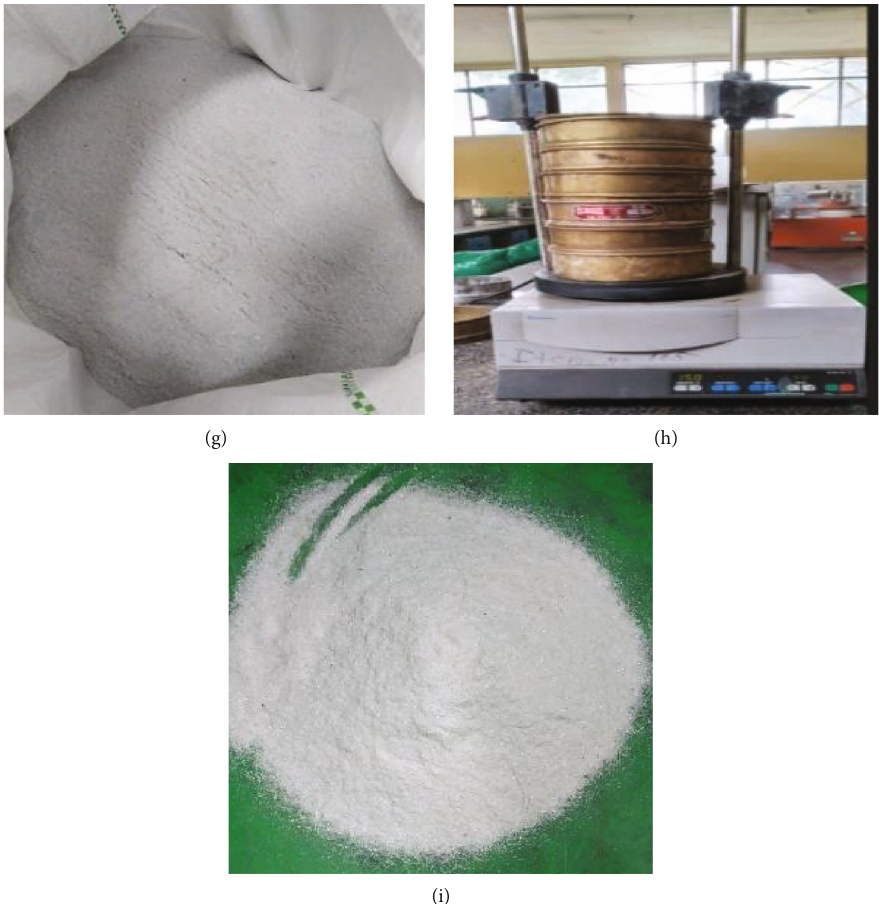
Figure 2: Grinding of waste glasses: (a) waste glass collecting, (b) washing, (c) drying, (d) jaw crusher, (e) glass particles after jaw crusher, (f) disk miller, (g) glass particles after disk miller, (h) sieve analyzer, and (i) 0.75-1.0mm sieve size glass